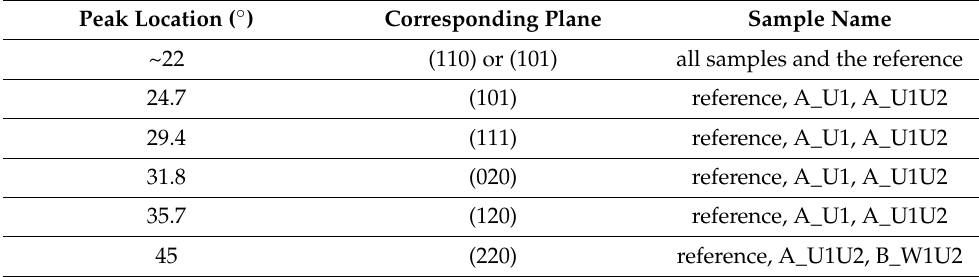
Table 3. Peak locations with corresponding planes for carbon structures and urea solution. Peak Location ( ◦